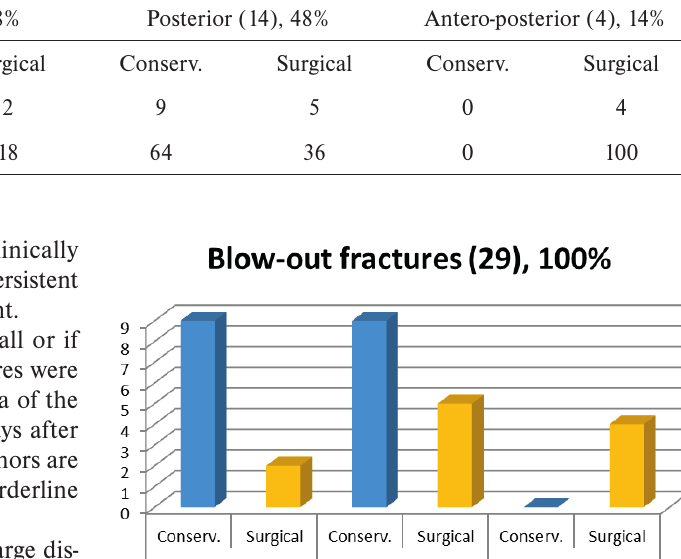
Table 5. The frequency of blow-out fractures by location and the relationship between conservative and surgical therapy. Fracture location Treatment Conserv.